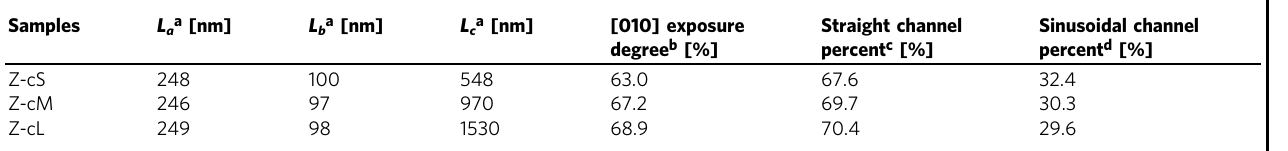
Table 1 Morphology parameters of the as-synthesized H-ZSM-5